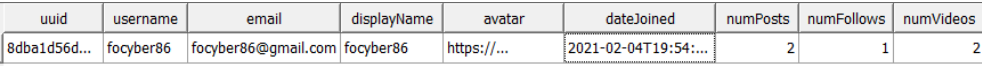
Figure 8. Reduced profile information for the Dubsmash Android